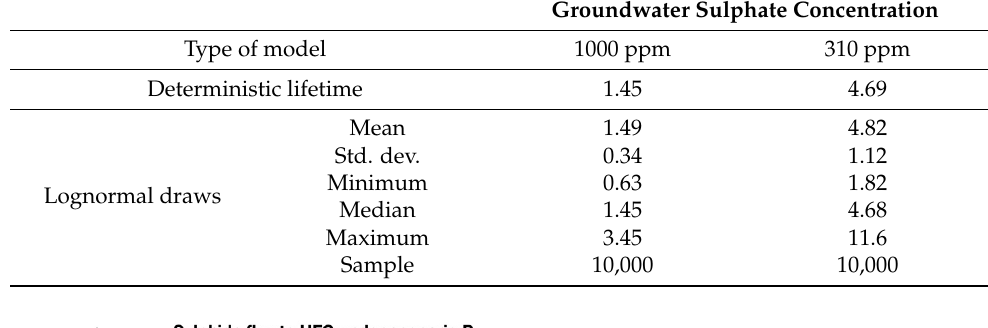
Table 6. UFC lifetimes under scenario B [10 6 years].